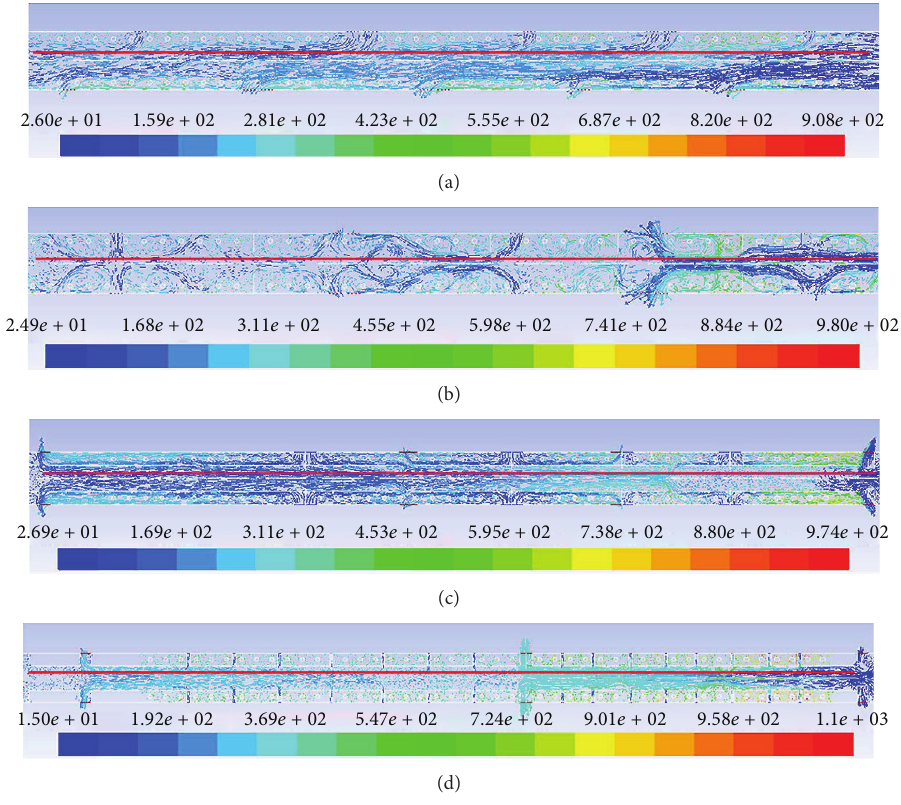
Figure 7: Velocity vectors and thermal distribution of the furnace for different settings of gas inlets and